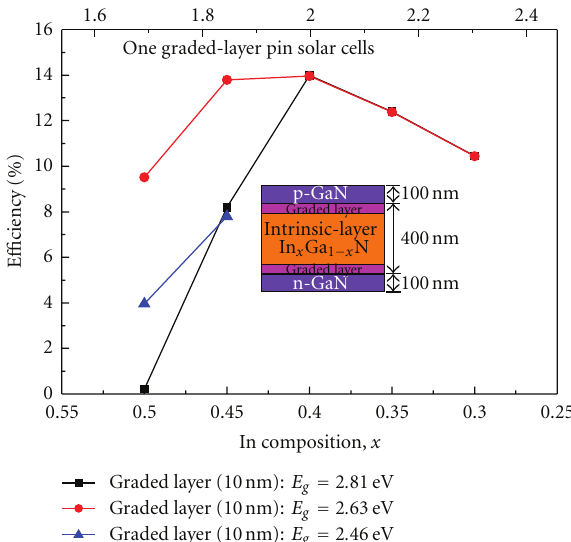
Figure 7: The e ffi ciency of one graded-layer pin solar cells as a function of In composition from 0.3 to 0.5.